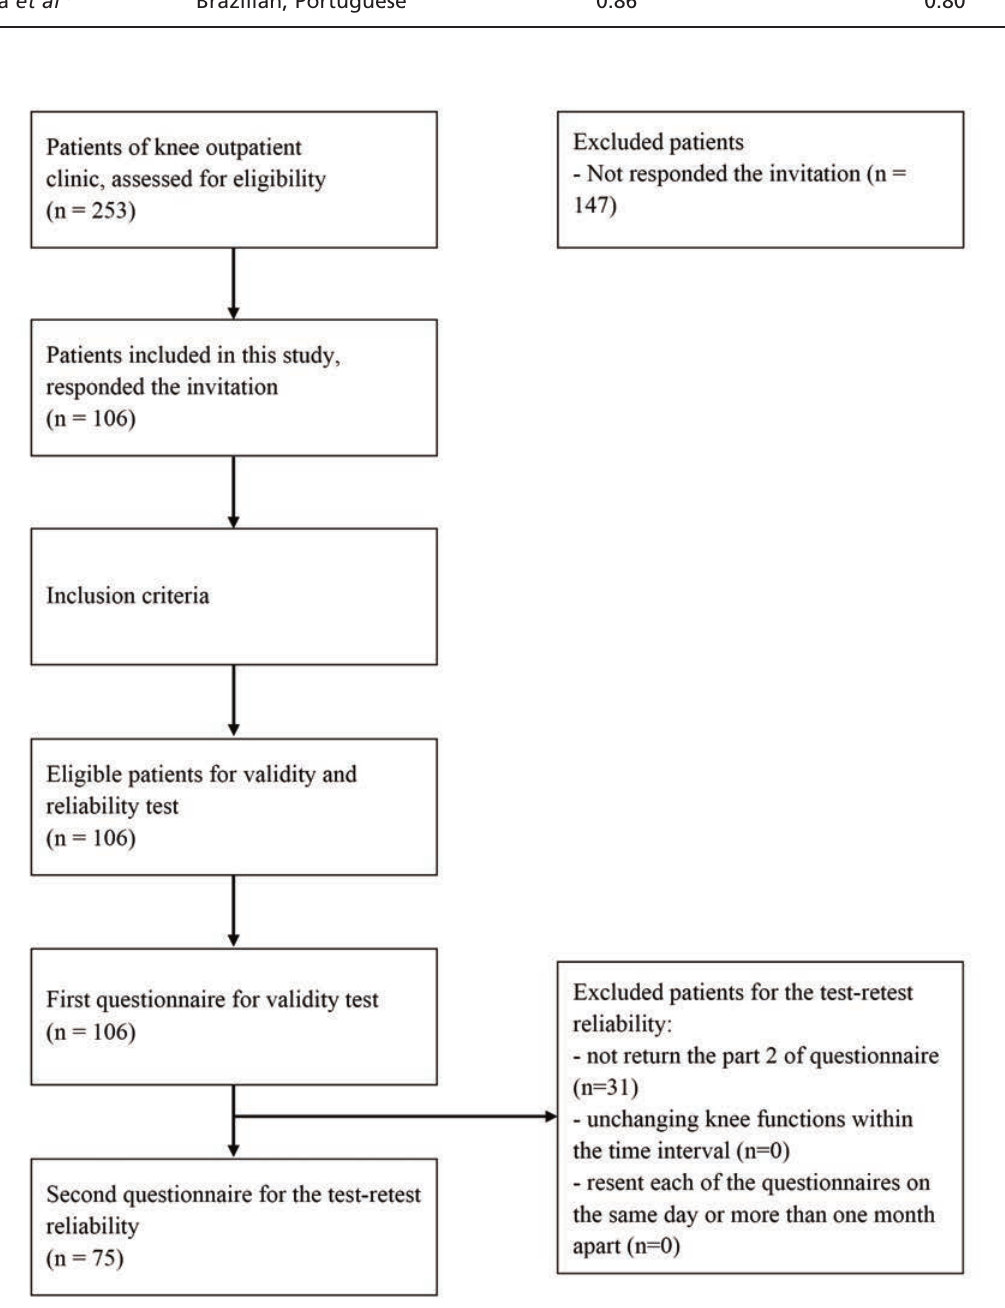
The framework of the study Fig. 1: